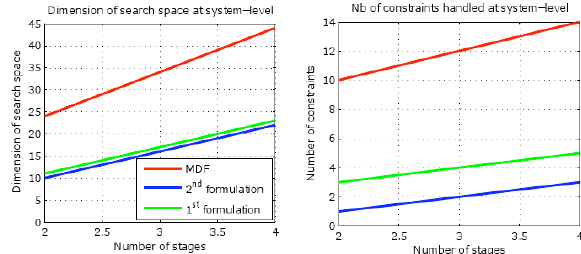
Fig. 8. Variations of search space dimension and number of constraints with respect to the number of stages Modularity